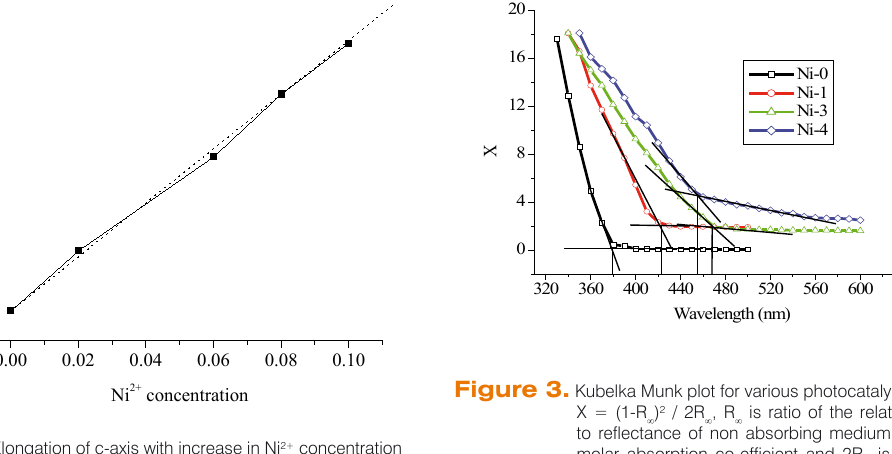
Figure 2. Elongation of c-axis with increase in Ni 2+ concentration